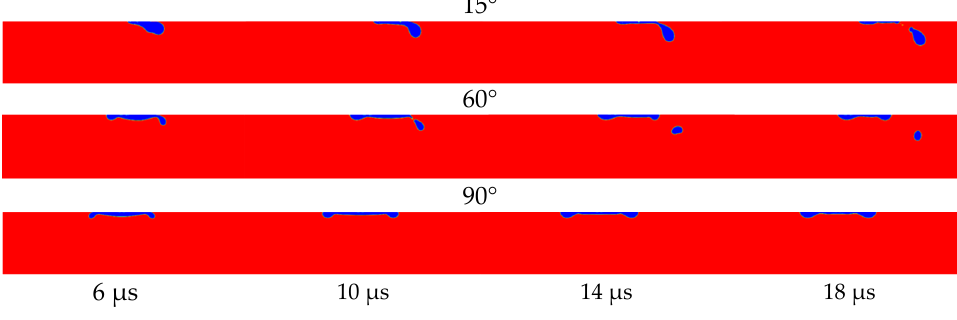
Figure 13. Dynamic evolution diagram of droplet impact process.